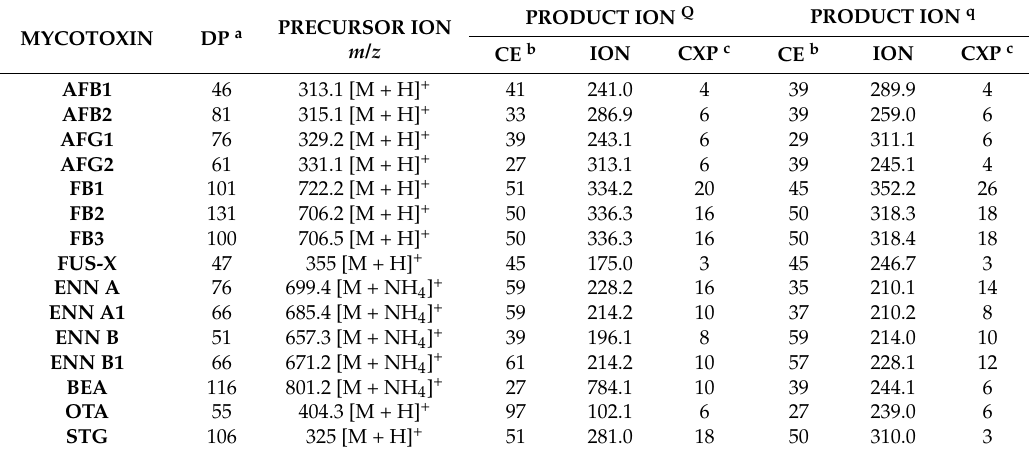
Table 1. Optimized parameters for the studied